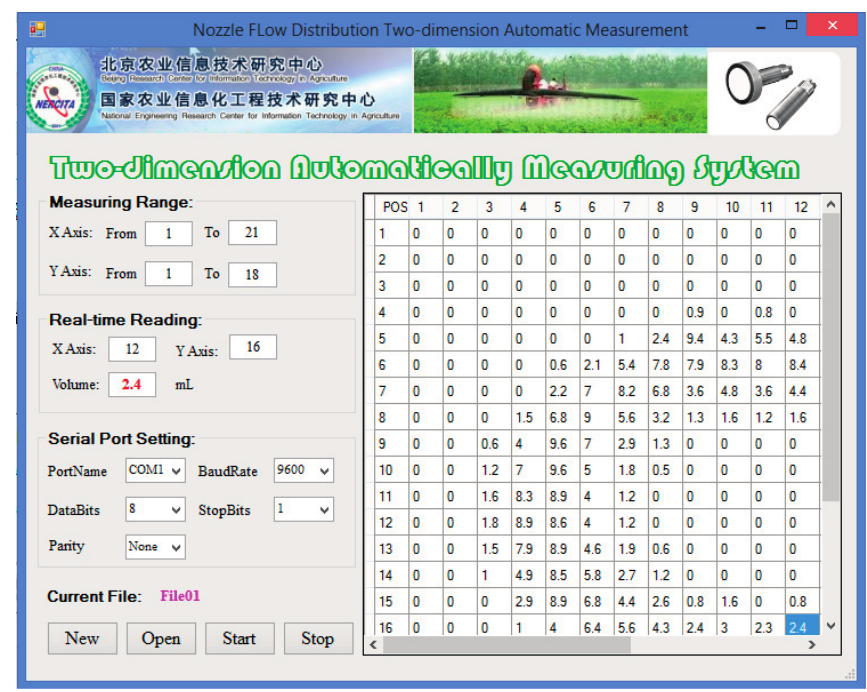
Figure 4. The computer software interface of nozzle flow distribution measuring